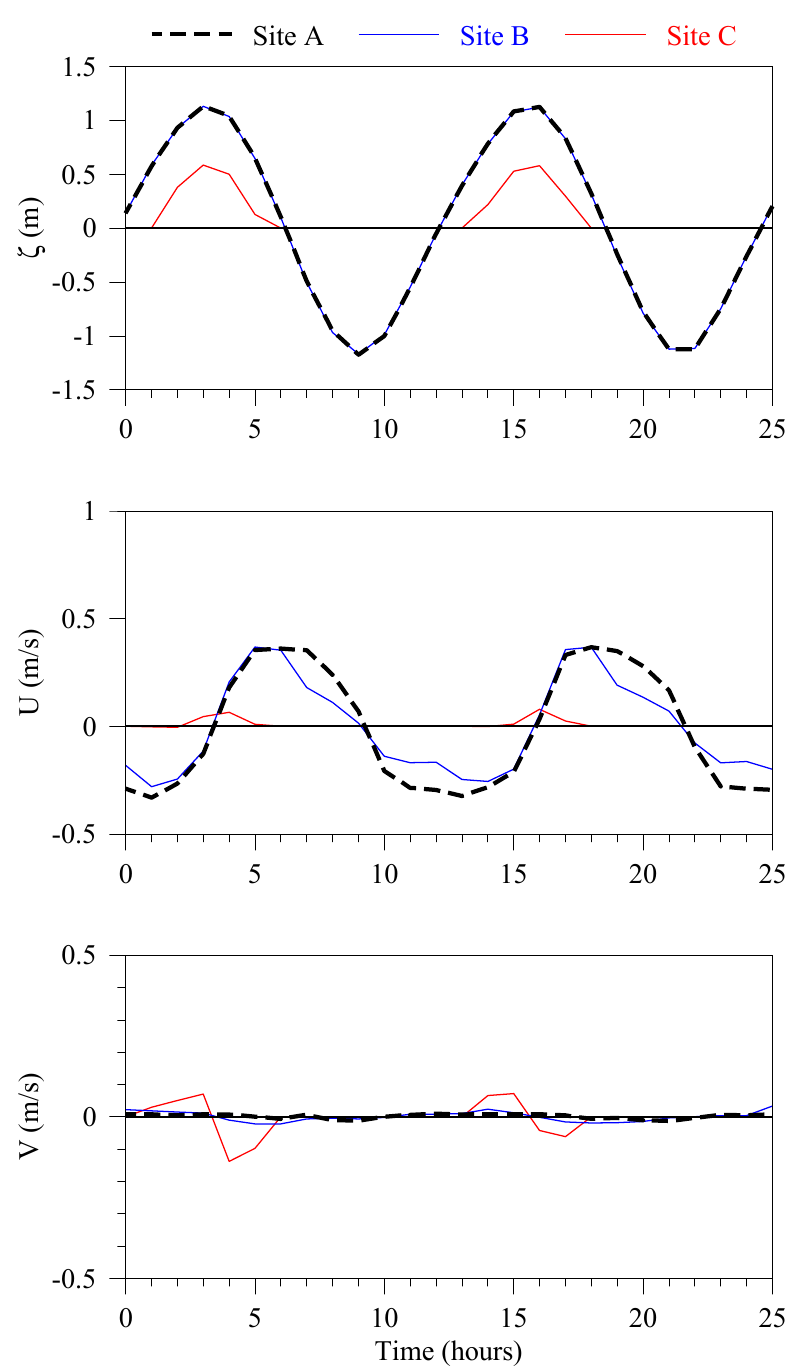
Figure 6. Time series of water elevation ( 𝜁 ) . along-channel ( U ), and cross-channel ( V ) at sites A, B, and C.